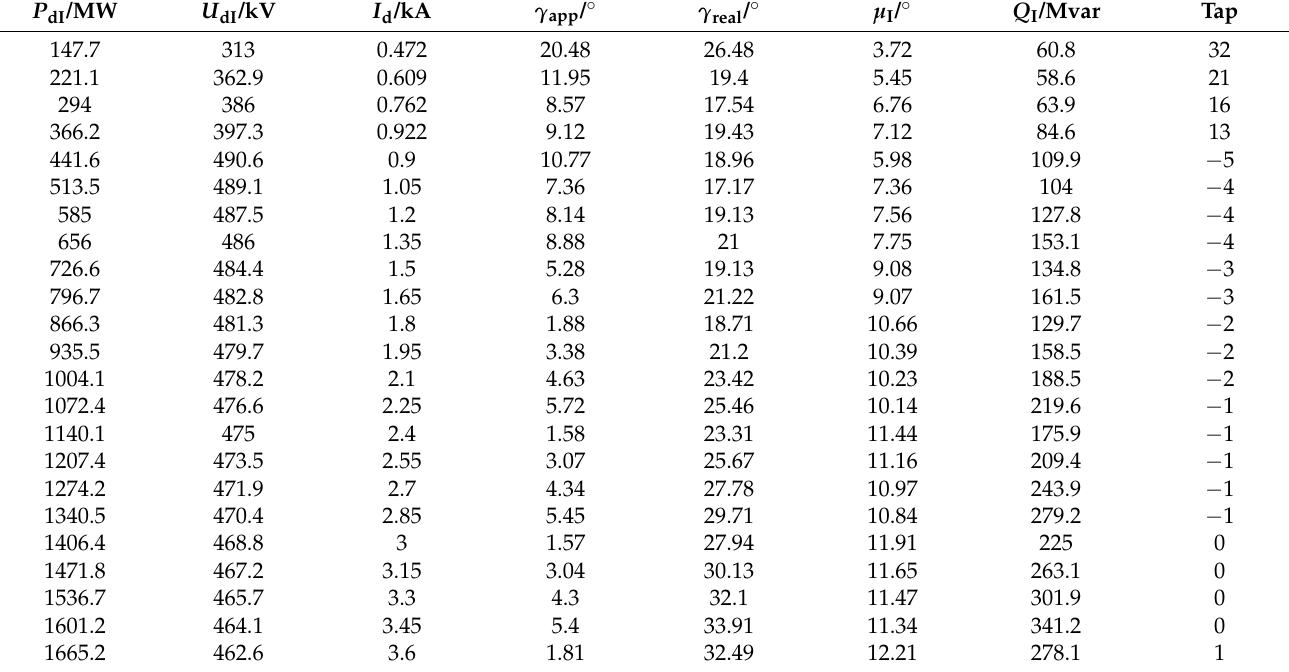
Table 7. Main circuit parameters at the inverter side (data per